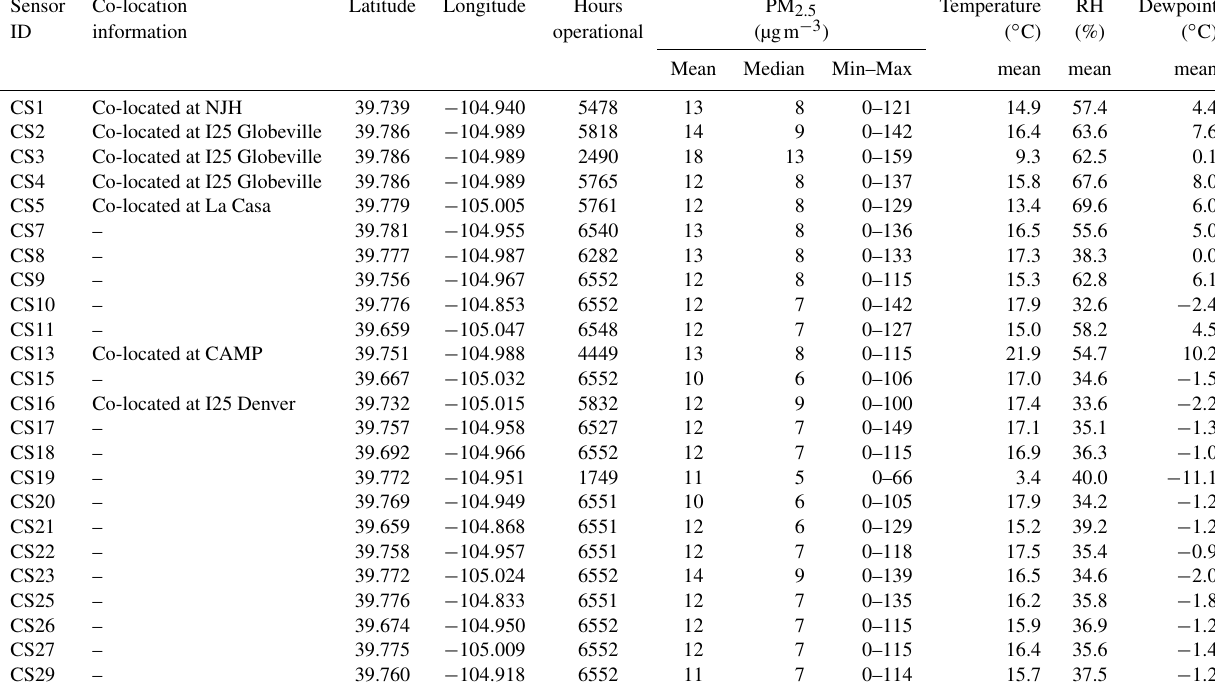
Table 1. Site location of each Love My Air sensor, as well as summary statistics of hourly measurements from each sensor. Sensor Co-location ID information